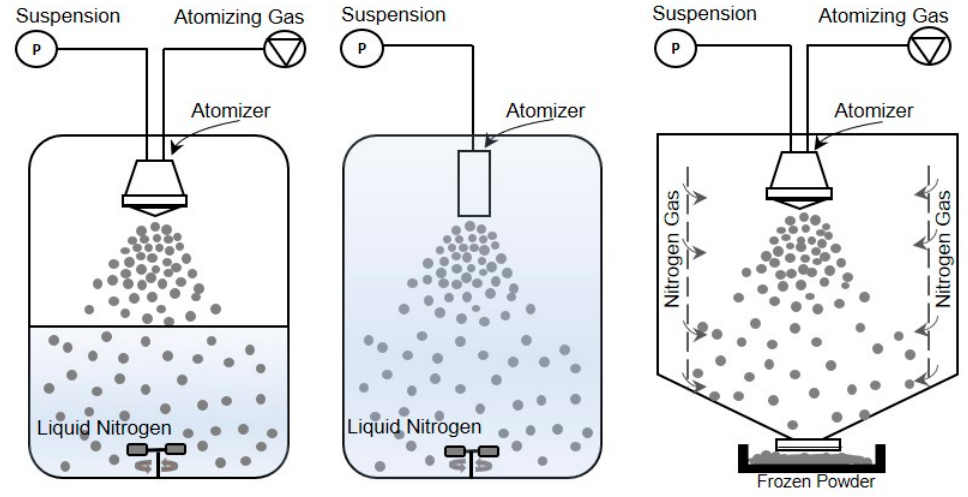
Figure 2. Illustration of different spray freezing techniques. ( left ) Spray freezing into vapor over liquid, ( middle ) Spray freezing into liquid, ( right ) Spray freezing into vapor.